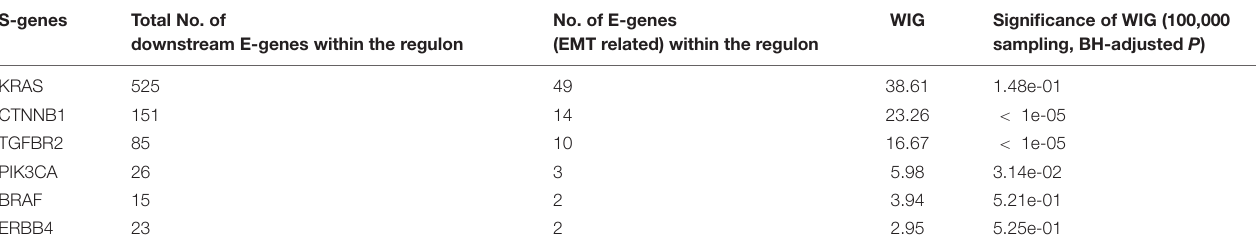
TABLE 4 | Double perturbations (kinase only) with top WIGs in CRC. S-genes Total No. of downstream E-genes within the regulon